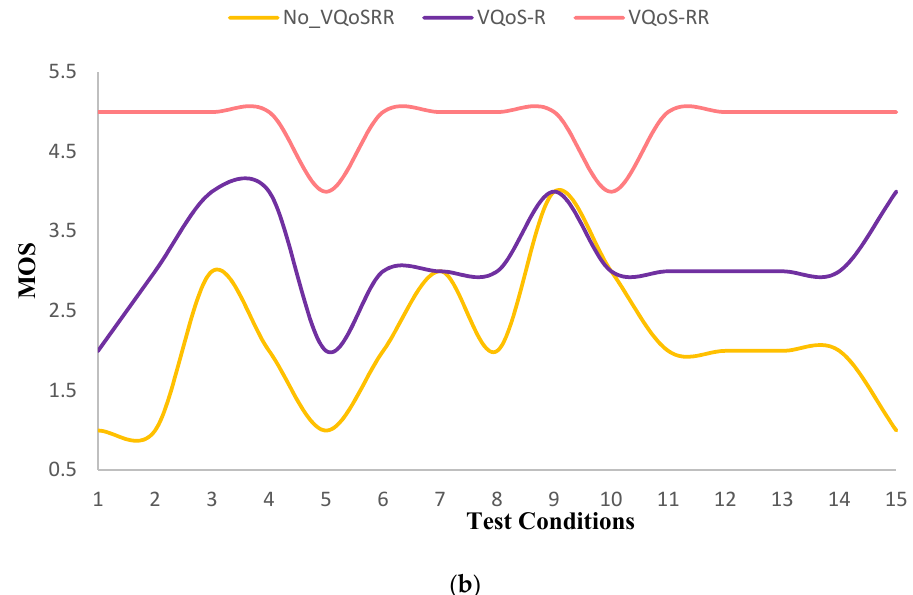
Figure 12. The MOS values of the tested videos . ( a ) SD resolution; ( b ) HD resolution.